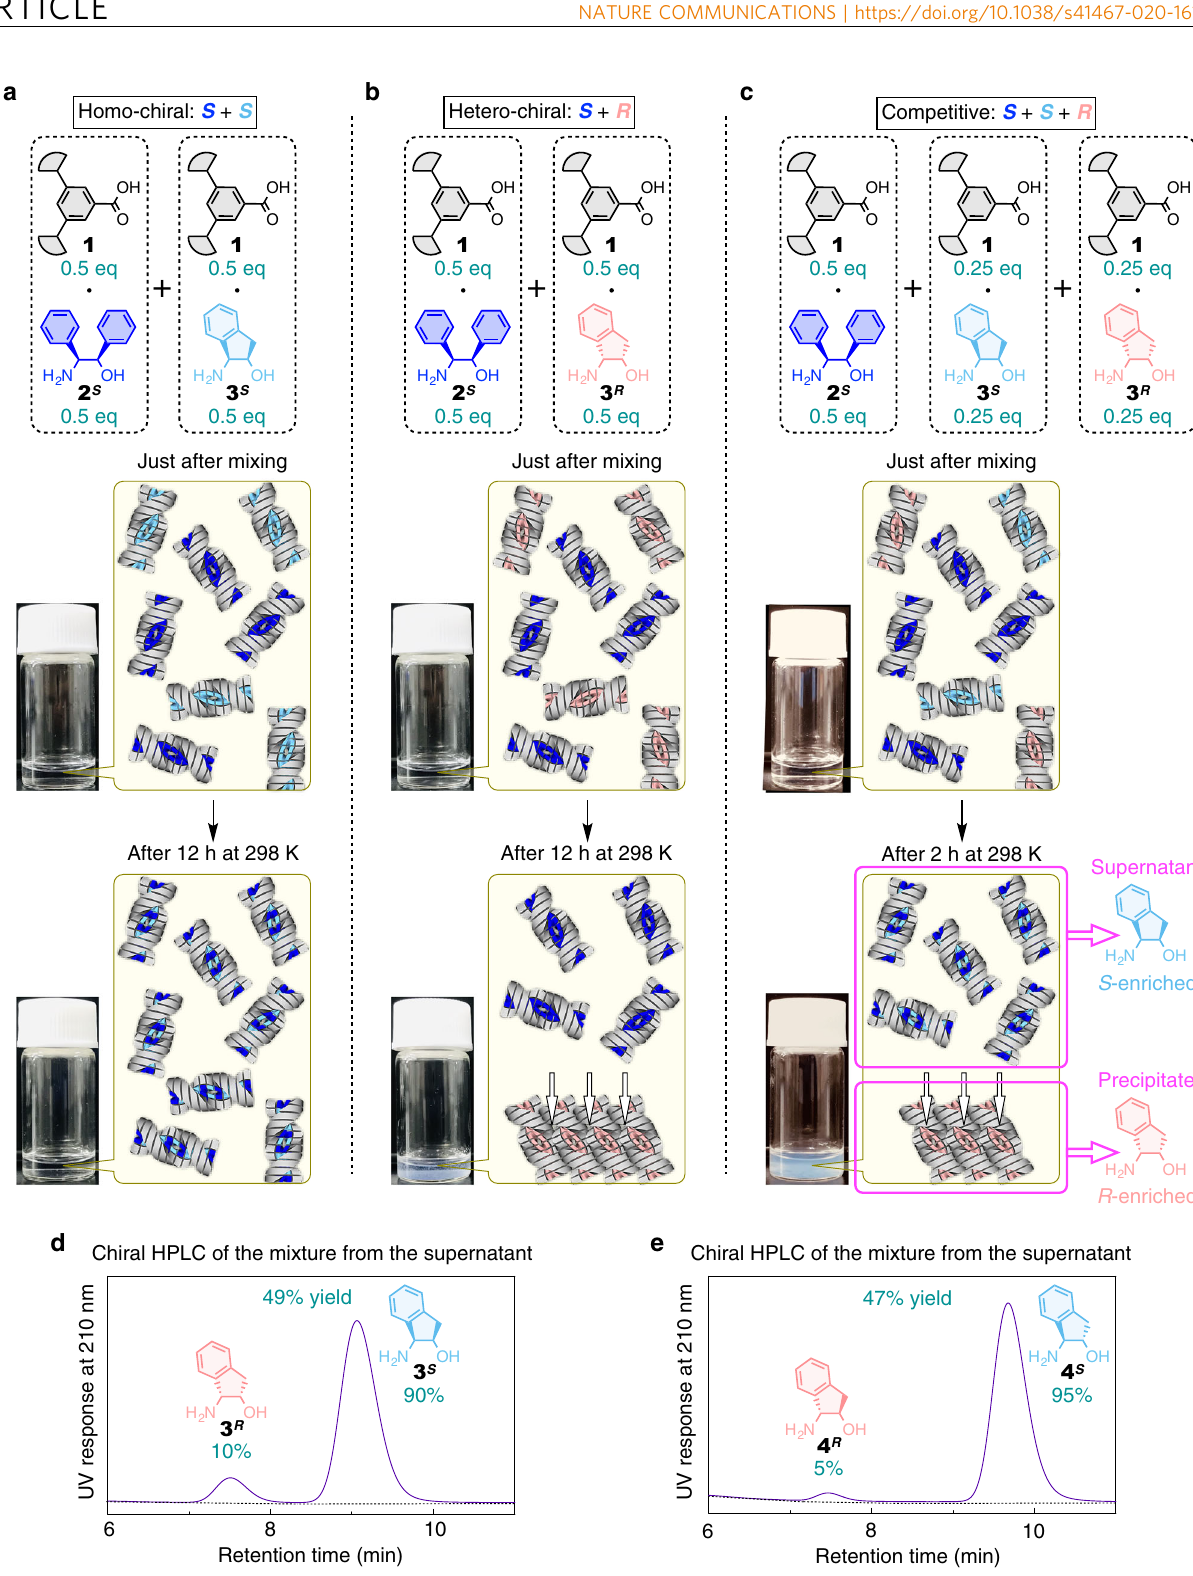
Fig. 6 Enantio-separation of amino alcohols by the helical supramolecular polymer. a – c Photographs and schematics of the supramolecular